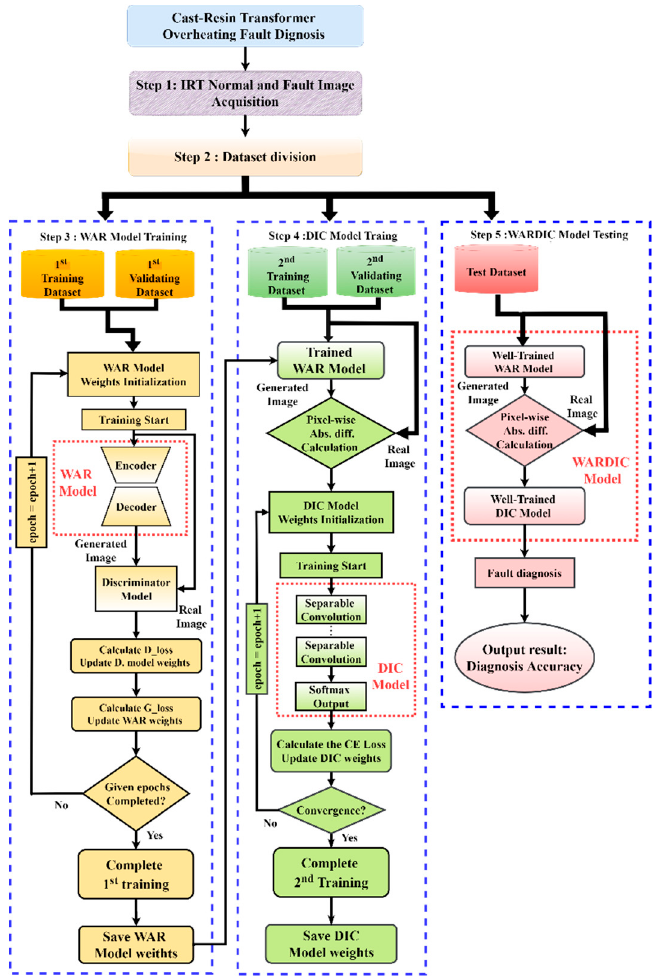
Figure 5. The flow chart of the proposed WAR-DIC overheating fault diagnosis